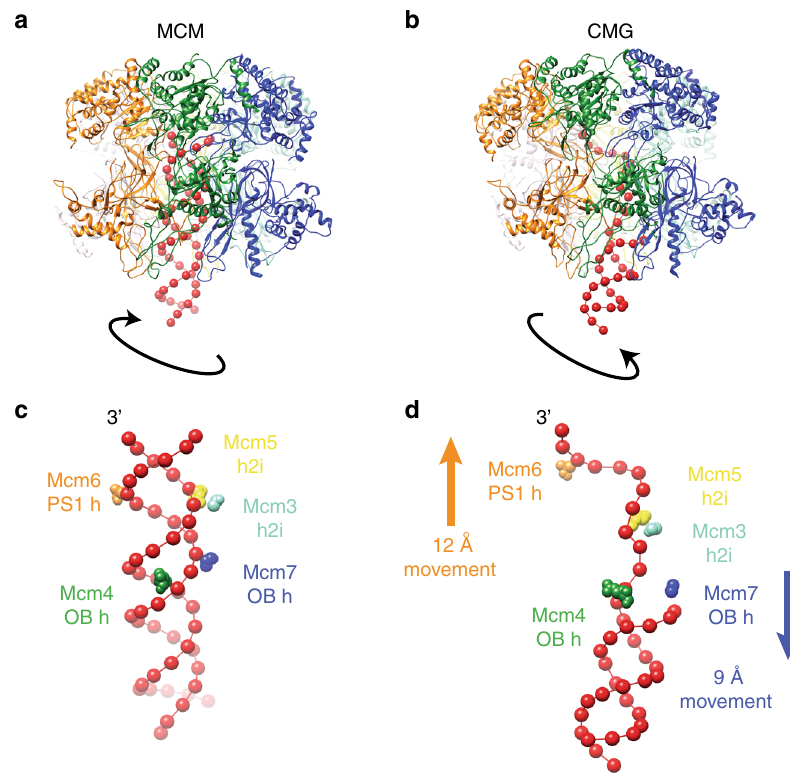
Fig. 5 A model for origin DNA opening: MCM-to-CMG transition causes DNA melting inside the helicase channel. a , b Duplex DNA encircled by the N- terminal MCM Zinc fi ngers becomes underwound as it transitions from MCM to CMG. Concomitantly, the ATPase-captured strand becomes stretched and untwisted inside the helicase pore. c MCM pore loop elements interacting with duplex DNA. Notably, ATPase pore loops Mcm6 PS1 h and Mcm3/5 h2i hairpins engage both the Watson and Crick strands. d MCM pore loops in the CMG touch the stretched and untwisted DNA. Mcm6 PS1 hairpin moves upwards by 12 Å. Mcm7 OB hairpin moves downwards by 9 Å and pushes against the DNA junction. Mcm4 remains fi xed in proximity to the DNA junction. Mcm3/5 h2i hairpins stabilize the stretched con fi guration of the ATPase-captured